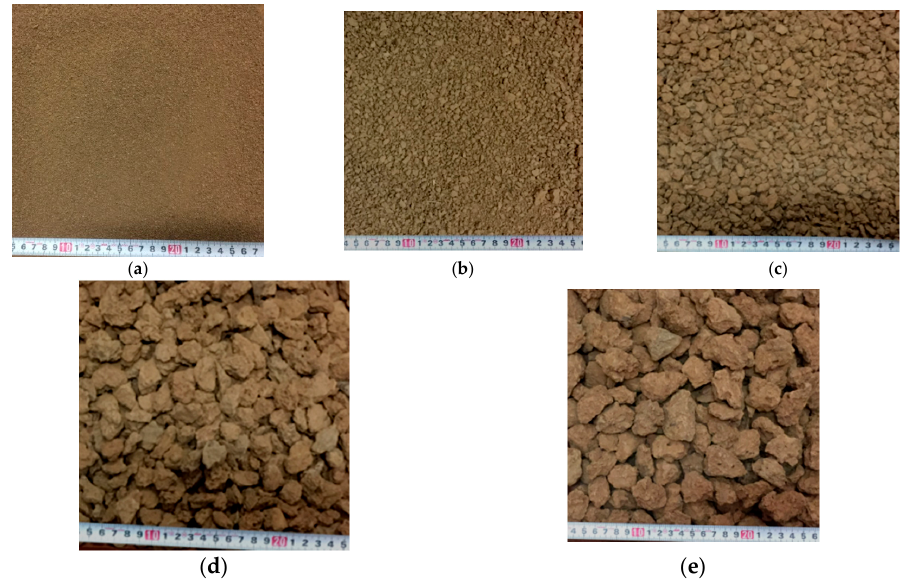
Figure 2. Each group of soil samples was subjected to five repeated sieving treatments. The collected soil was subjected to an image processing analysis, and the pore widths that corresponded to different particle sizes were counted to determine a large-pore soil model.